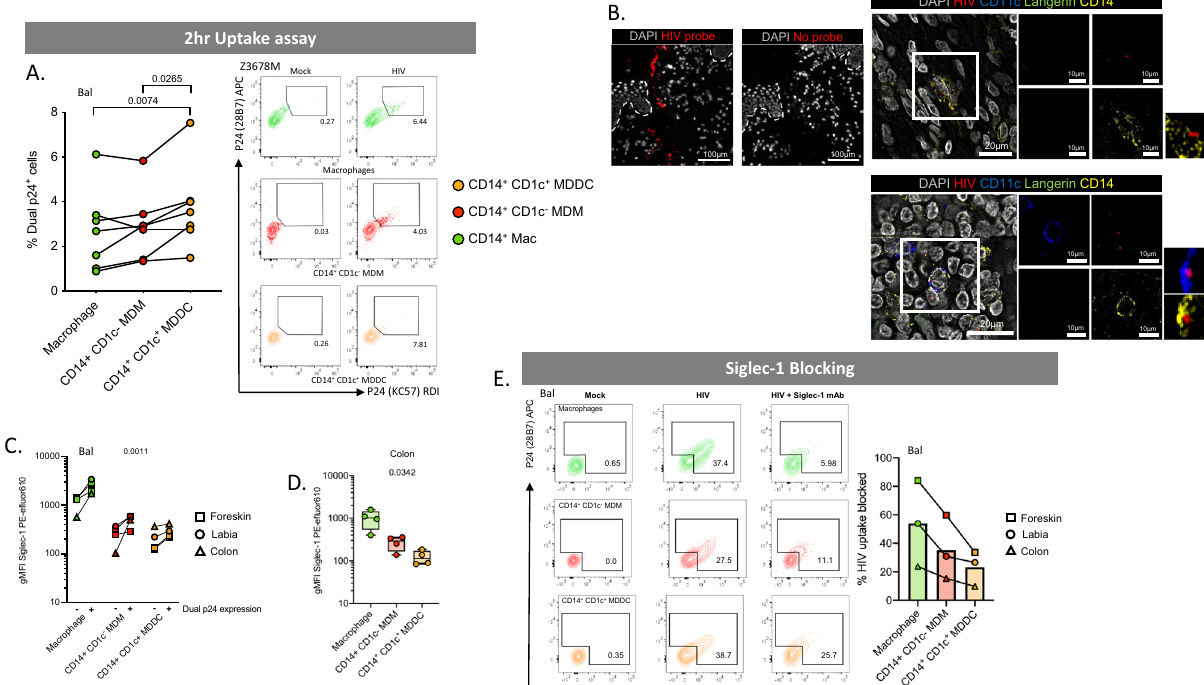
Fig. 5 HIV uptake of dermal CD14-expressing mononuclear phagocytes. A MNPs were liberated from human abdominal skin using and CD45 + HLA-DR + live cells FACS isolated. Mixed dermal populations were incubated for 2 h with HIV Bal or HIV Z3678M or mock treated, thoroughly washed and stained for surface markers and two antibody clones to HIV p24 (KC57 and 28B7) for fl ow cytometry analysis to determine percentage dual p24 + cells. Left: HIV Bal results graphed with each donor represented by individual dots, donor matched by connected lines ( n = 7). Statistics were generated using RM one-way ANOVA with Holm-Sidak ’ s multiple comparisons with adjusted P values shown. Right: representative contour plots for HIV Z3678M shown, gating on dual p24 + cells for each subset. B Human penile urethra explants were treated with HIV for 2 h before being fi xed and paraf fi n embedded. After sectioning, HIV RNA was visualised using RNAscope and immuno fl uorescent staining for langerin, CD11c, CD14 and DAPI. Left: representative images of one donor, with and without the addition of the HIV speci fi c RNAscope probe. Right: macrophages and CD14 + CD1c − cells could not be individually distinguished from each other but could be visualised as a group (top) while CD14 + CD1c + cells could also be visualised interacting with HIV (red) (bottom). Representative images from n = 3 donors. C Human MNPs from anogenital/colorectal tissue (2x foreskin: squares, 1x labia: circle, 1x colon: triangle), were treated as in A . The expression of Siglec-1 was assessed by geometric mean fl uorescence intensity (gMFI) minus matching FMO control, on dual p24 + cells vs p24 − cells. Each dot represents an individual donor with lines matching the same donor for each subset. Statistics measured the difference in p24 + cells versus p24 − cells using a three-way ANOVA. D Siglec-1 expression on CD14-expressing subsets was determined in n = 4 colon donors. plotted as box and whisker plots, box representing the upper and lower quartile, central line representing the median, the whiskers the minimum and maximum of each cell subset and each donor represented by an individual dot. Statistics generated using RM one-way ANOVA. E Mixed dermal MNPs were treated as above however before incubation with HIV, cells were pre-treated with Siglec-1 mAb for 30 min. Left: representative plot of HIV uptake assessed by dual p24 + cells in Mock, HIV treated and HIV + Siglec-1 mAb samples from foreskin donor. Right: percentage of HIV uptake that was blocked using Siglec-1 mAb across three donors of anogenital/colorectal tissue (foreskin: square, labia: circle, colon: triangle), with each point representing individual donors matched with joining lines, and column representing mean. Macrophages (green), CD14 + CD1c − MDM (red) and CD14 + CD1c +